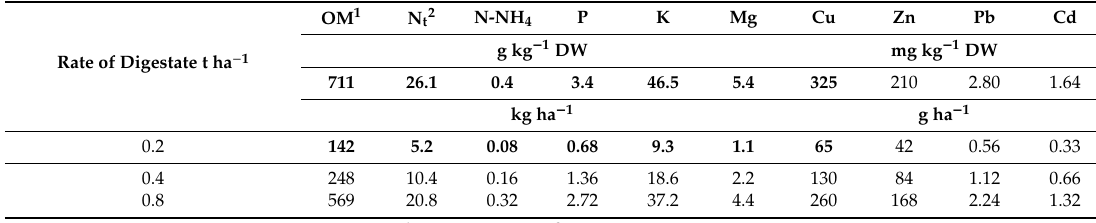
Table 2. Chemical composition and rates of elements applied with consecutive rates of digestate.